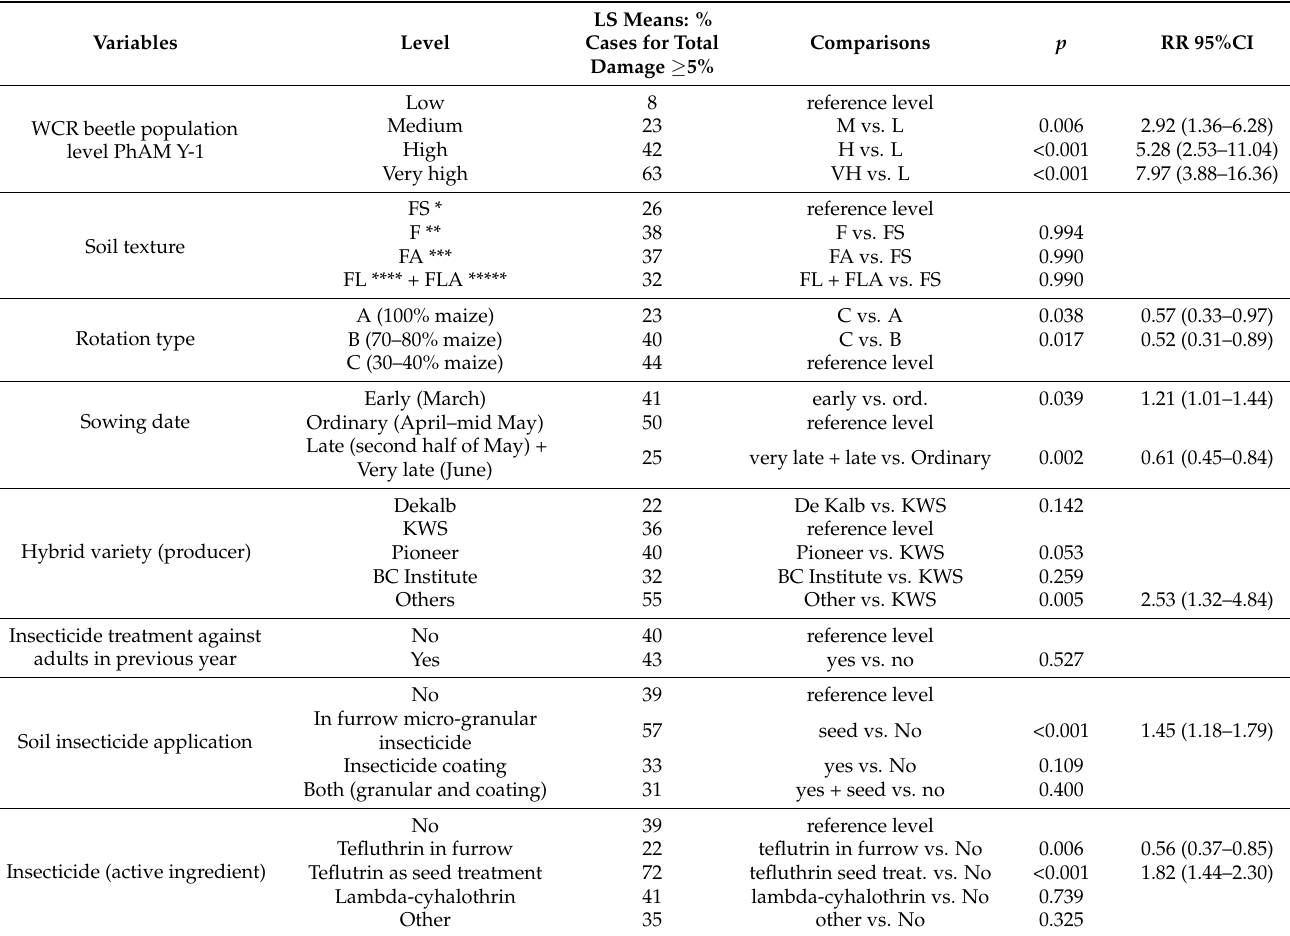
Table 4. Univariate risk analysis establishing the risk of plant damage (gooseneck + lodged plants) exceeding